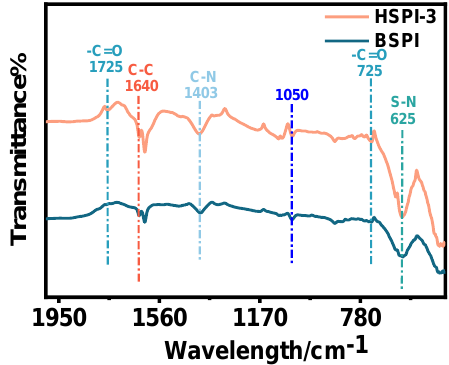
Figure 4. FT-IR spectra of HSPI-3 and BSPI sample.